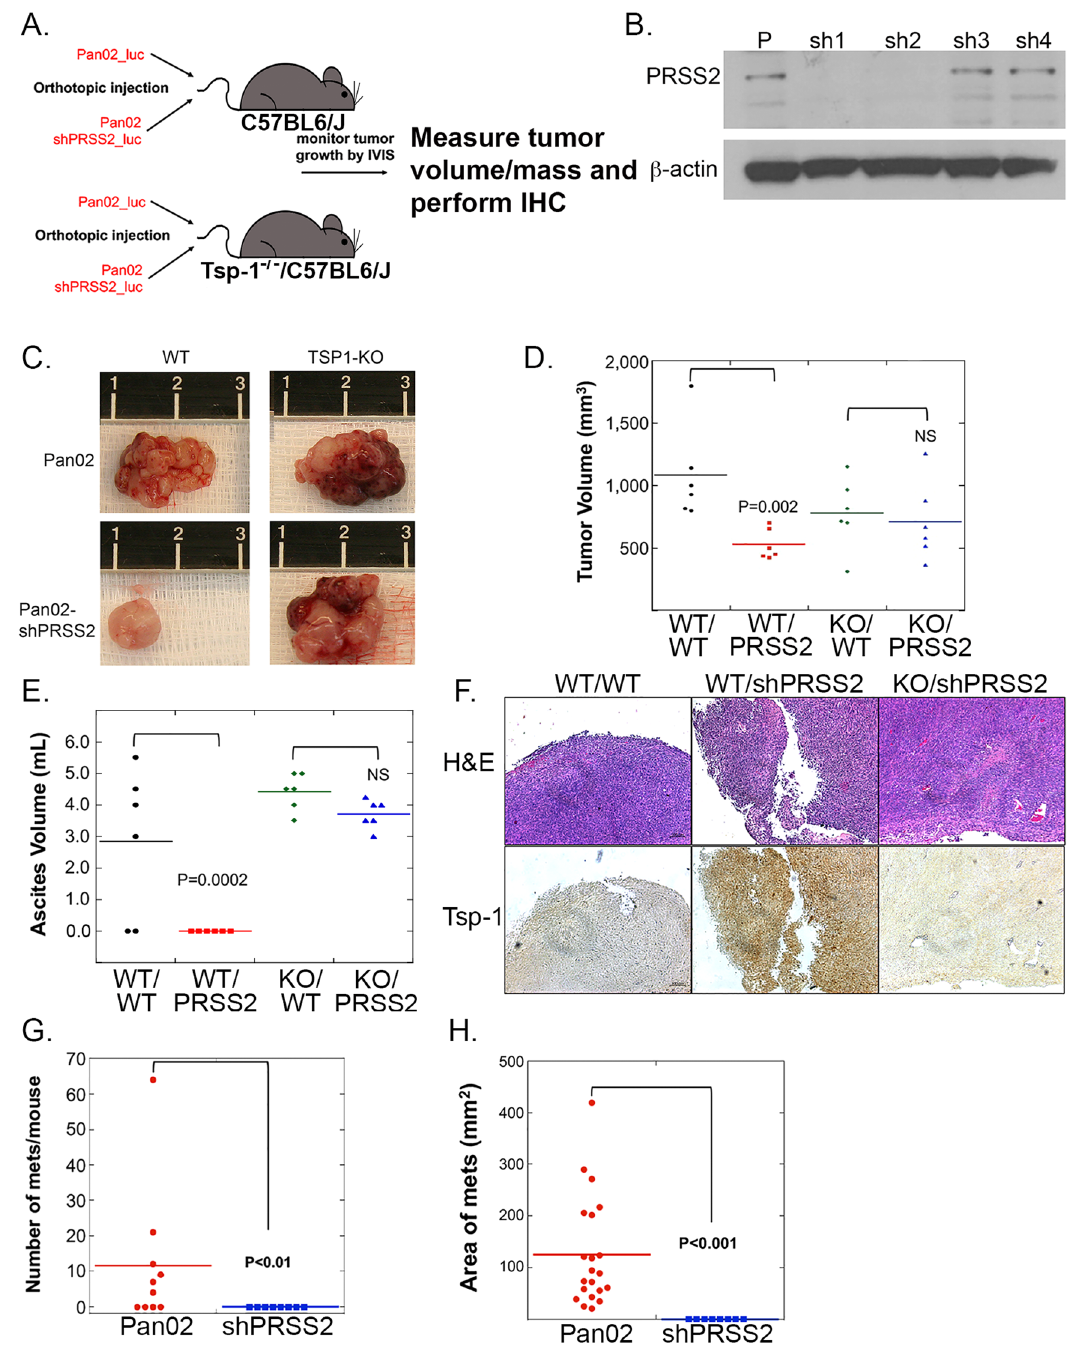
Fig. 5 | Silencing PRSS2 inhibits primary pancreatic tumor growth and metas- tasis. A Schematic of tumor implantation strategy. B Western blot of PRSS2 and actin in Pan02 cells transduced with lentiviral vectors specifying 4 shRNA sequences against murine PRSS2. C Photographs of tumors formed by Pan02 and Pan02shPRSS2 (sh1 from 4B) cells in wild-type C57Bl6/J mice and thbs1 − / − C57Bl6/J mice. D Dot plot of mass of tumors formed by Pan02 and Pan02shPRSS2 cells in wild-type C57Bl6/J mice and thbs1 − / − C57Bl6/J mice ( n =6 per group; P value cal- culatedviatwo-sidedMann – Whitney U test). E Dotplotofascitesvolumeoftumors formed by Pan02 (WT n =6; thbs1 − / − n =6) and Pan02shPRSS2 (WT n =6; thbs1 − / − n =6)cells inwild-type C57Bl6/J miceand thbs1 − / − C57Bl6/Jmice( P valuecalculated via two-sided Mann – Whitney U test). F H&E and Tsp-1